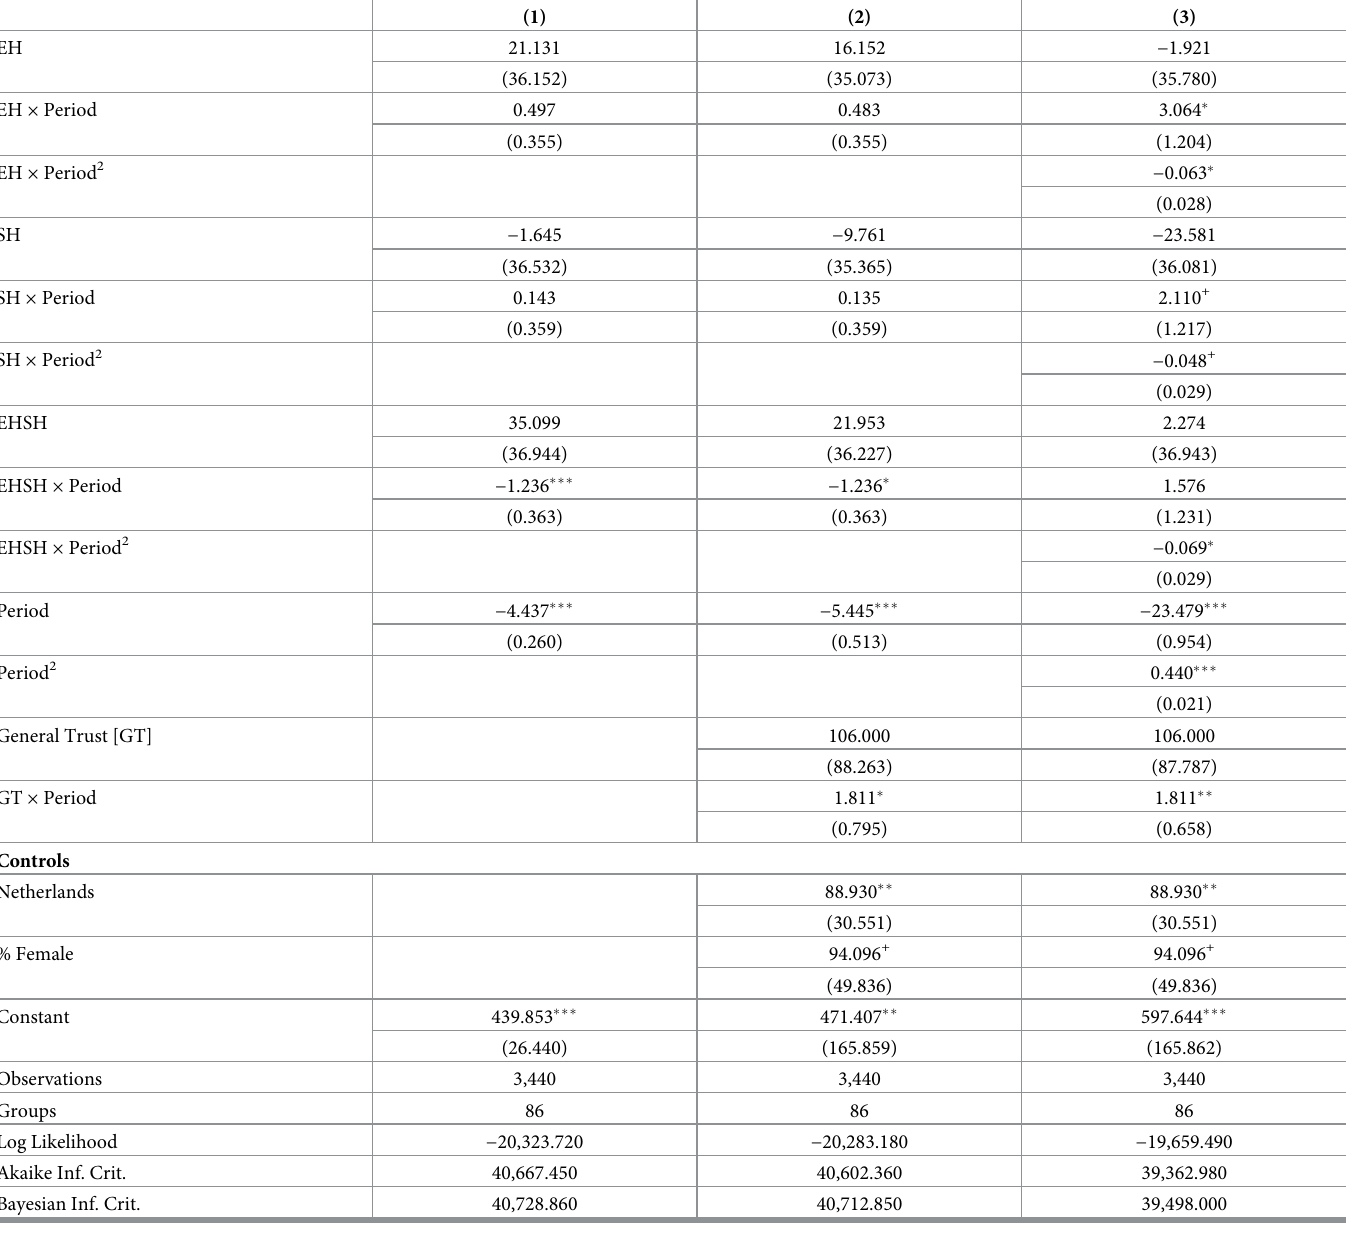
Table 3. Two-level multilevel regression on resource size with random intercepts for